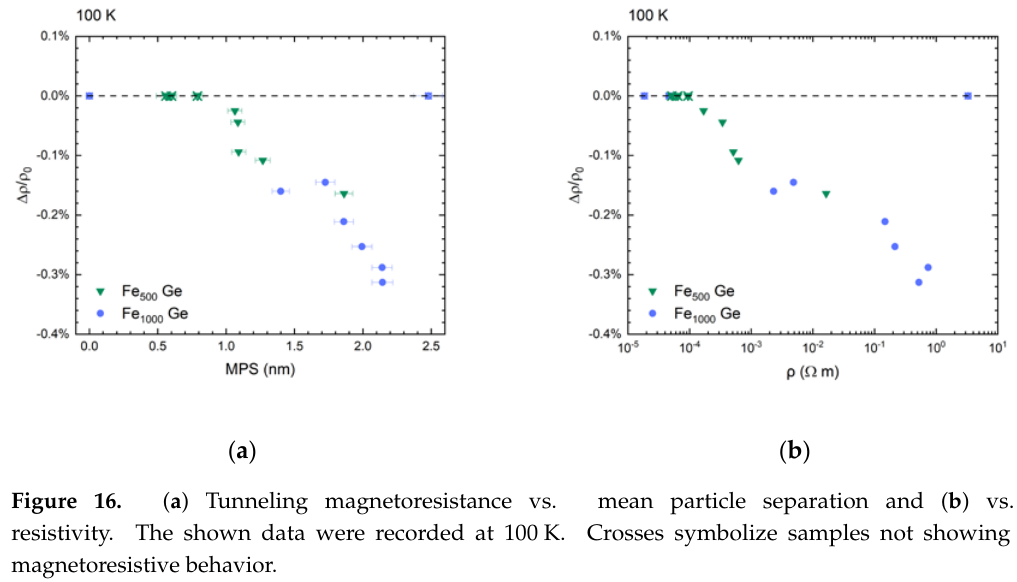
Figure 16. ( a ) Tunneling magnetoresistance vs. mean particle separation and ( b ) vs. resistivity. The shown data were recorded at 100 K. Crosses symbolize samples not showing magnetoresistive behavior.